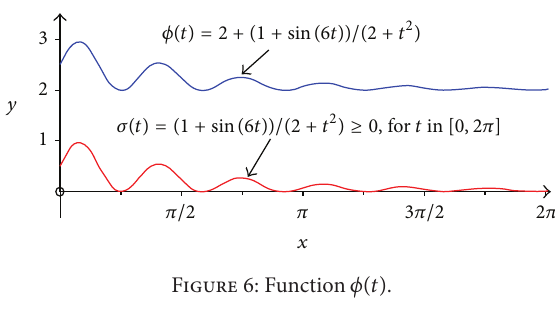
Figure 4: Function 𝑓(⋅) .